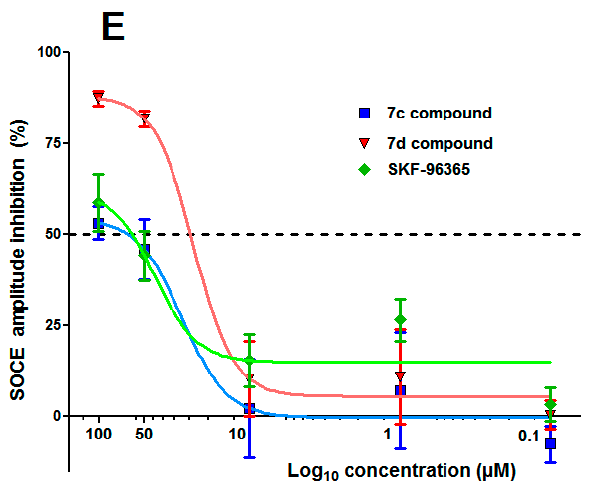
Figure 3. Effect of compounds 7c , 7d , and SKF-96365 compounds on ER Ca 2+ release and store-operated Ca 2+ entry (SOCE). ( A – D ) showed typical representative traces of intracellular Ca 2+ concentration variations measured with Fura-2 dye in PLP-B lymphocyte cell line when SOCE activation protocol is implemented. Tested compounds 7c , 7d , and SKF-96365 were added 3 min before recording intracellular Ca 2+ level variation with the FlexStation 3™ plate reader. Endoplasmic reticulum (ER) Ca 2+ content is first totally depleted in Ca 2+ free medium by injection of 2 µ M Thapsigargin (Tg) and SOCE is next measured by addition of 1.8 mM Ca 2+ in the extracellular medium; ( D ) Representative traces of the SOCE Ca 2+ signals recorded after ER Ca 2+ stores releases with Tg in cells treated with 7c , 7d , and SKF-96365 compounds (100 and 1 µ M). SOCE amplitudes in the presence of the different drugs are normalized to vehicle control; ( E ) 7c , 7d , and SKF-936365 compounds inhibition dose-response curves: points represented the mean ± SEM of three different experiments and expressed as the percentage of SOCE Ca 2+ entry amplitude inhibition on PLP-B Lymphocyte cell line normalized to vehicle control (100%).